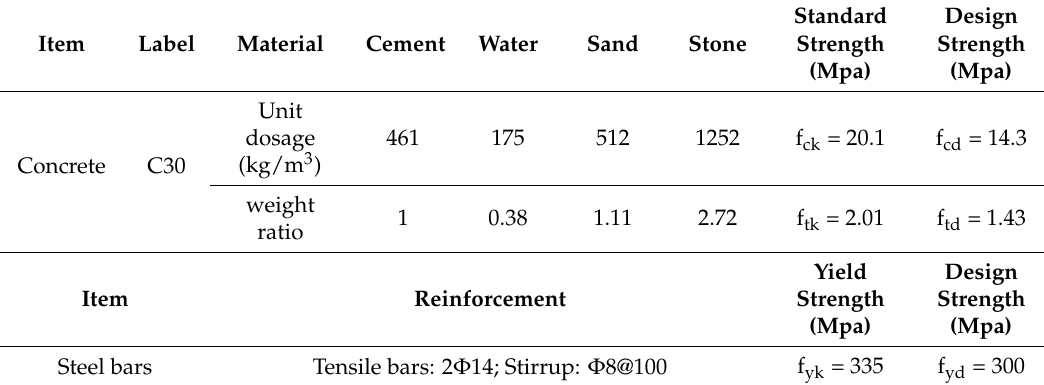
Table 1. Material parameters of tested beam.